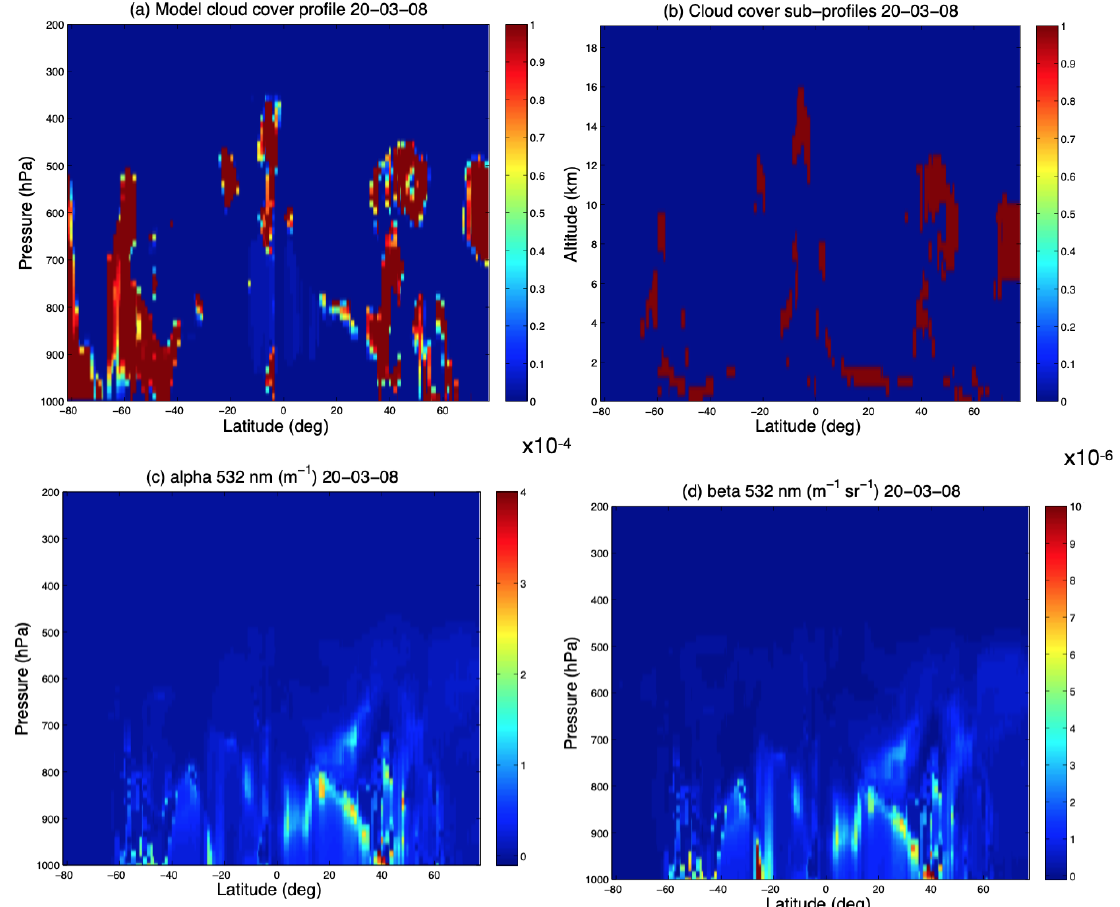
Figure 3. (a) Vertical profiles of cloud fraction simulated by the E3SMv1 model along the satellite orbit on 20 March 2008; (b) same vertical profiles, defined by the COSPv2 simulator at the sub-grid scale and interpolated on 40 vertical levels; (c) aerosol extinction profiles (in m − 1 ) and (d) aerosol backscatter coefficient profiles (in m − 1 sr − 1 ) calculated by E3SMv1 along the satellite